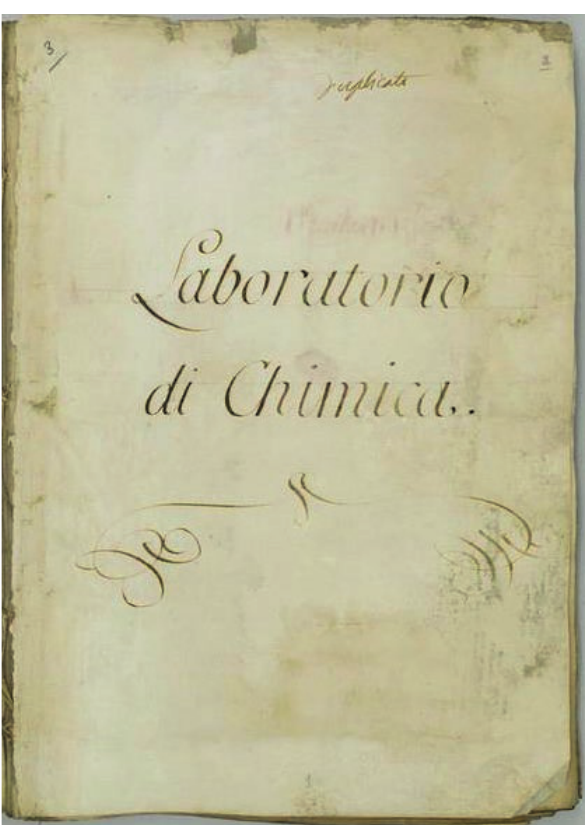
Figure 3. Frontispiece chemistry cabinet’s catalog. Biblioteca del Museo Galileo, Firenze.